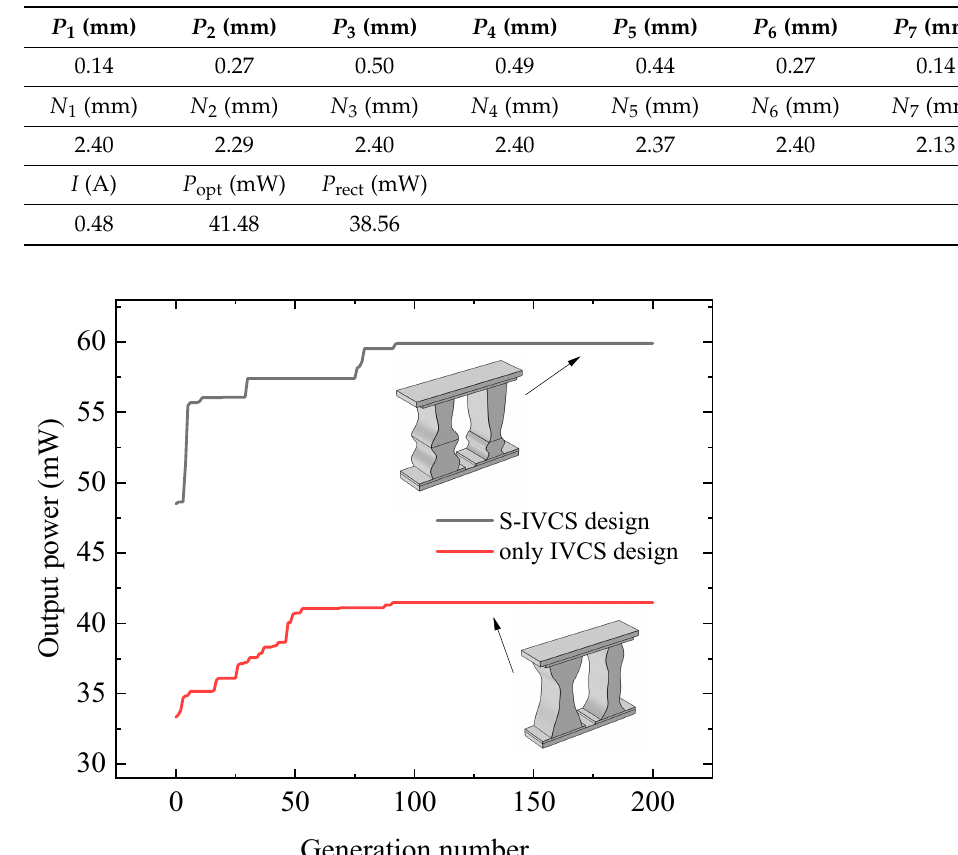
Figure 8. The output power as a function of generation number during the optimization. Table 3. The design parameters of the S-IVCS optimization.